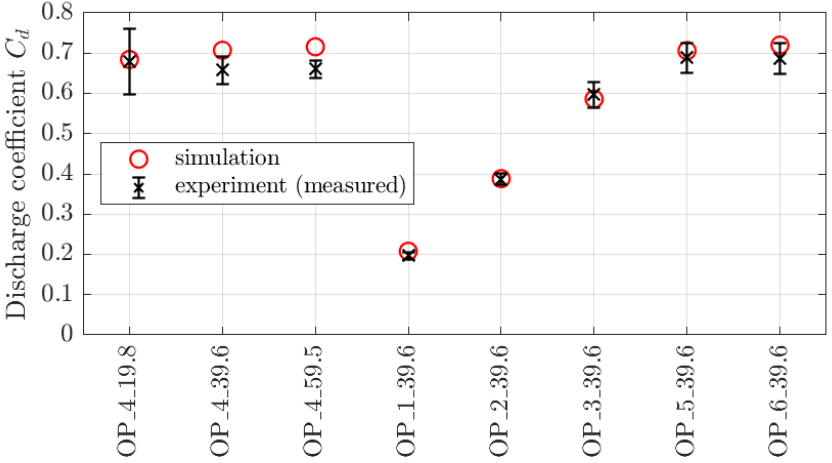
Figure 13. Comparison of calculated and measured discharge coefficients for all conducted Figure 13. operation points.